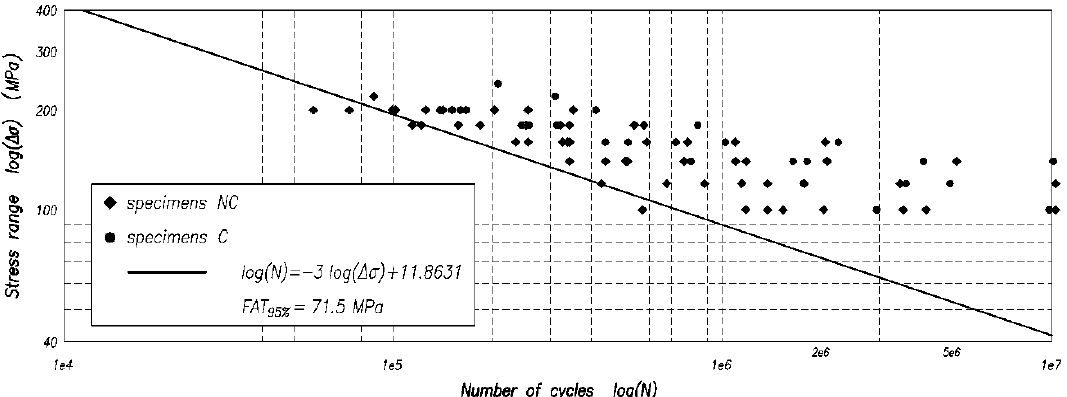
Figure 16. S-N curve with m = 3 for welded joints with and without defects (type-C and -NC specimens, respectively).